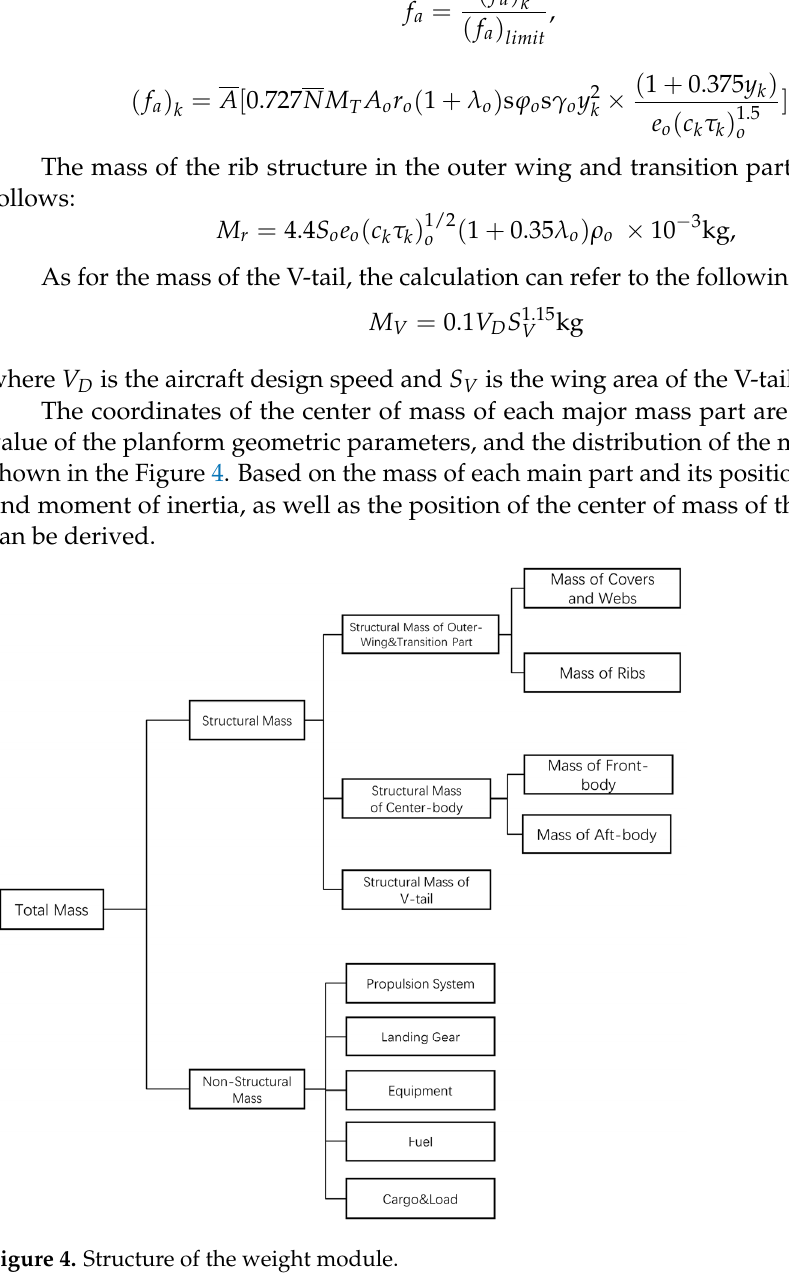
Figure 4. Structure of the weight